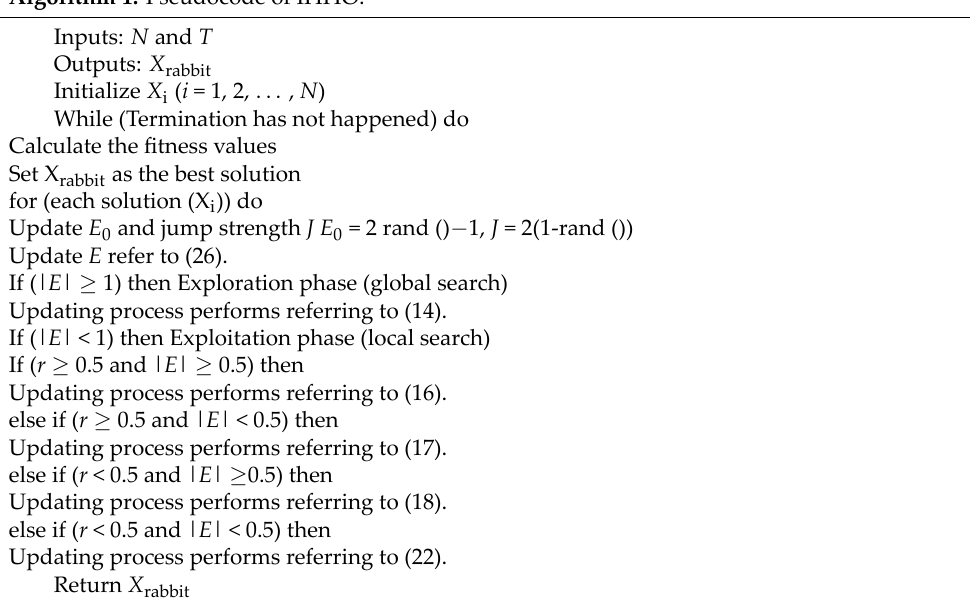
Algorithm 1. Pseudocode of